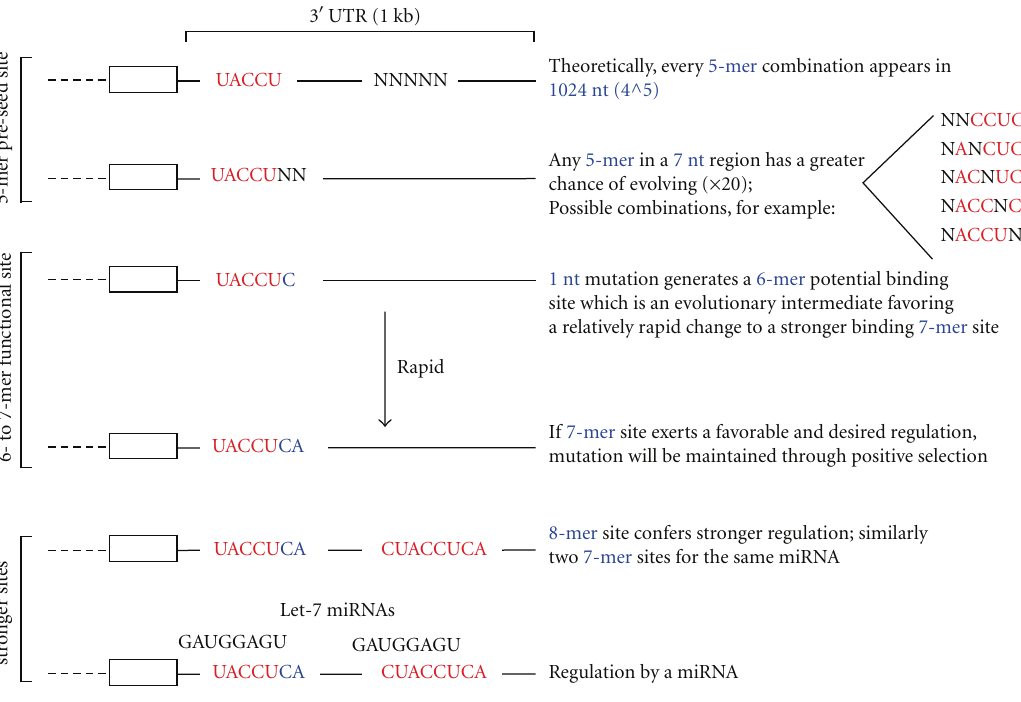
Figure 4: A possible scenario for acquiring a functional miRNA binding